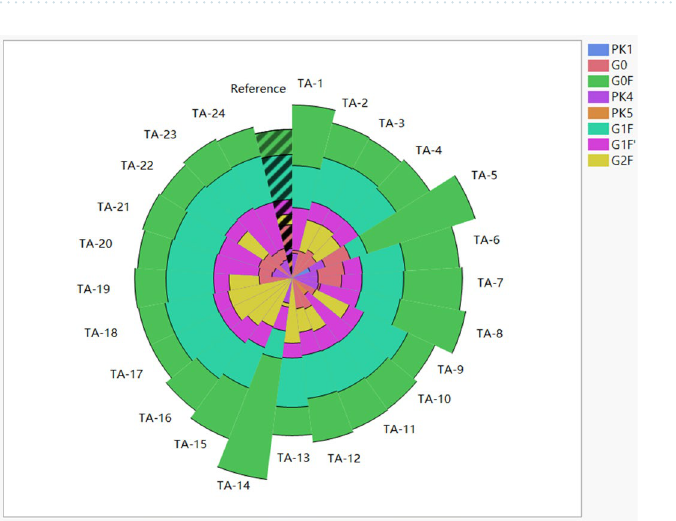
Figure 3. The HPLC chromatogram of glycan distribution. Compared to standards, peaks of G0, G0F, G1F, G1 ′ F and G2F are indicated. PK1, PK4 and PK5 refers to the 3 minor unidentified peaks, respectively. The chromatogram was created by Agilent OpenLab CDS 2.0 (https:// www. agile nt. com/ en/ produ ct/ softw are- infor matics/ analy tical- softw are- suite/ chrom atogr aphy- data- syste ms/ openl ab- cds).